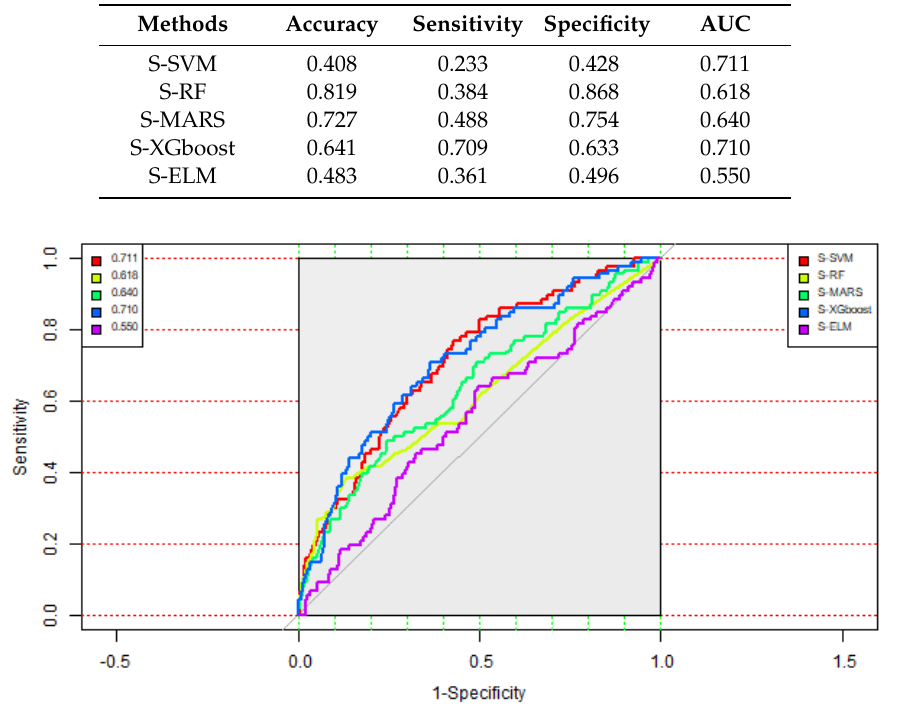
Figure 3. ROC (Receiver Operating Characteristic) curves of the five single methods.